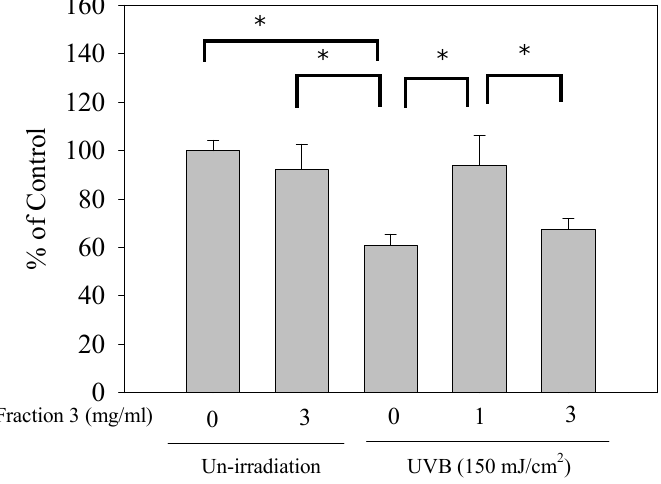
Figure 5. Effects of Fraction 3 on catalase activity. Data is shown as mean ± S.E. (n = 4). * p < 0.05 compared to the control group.